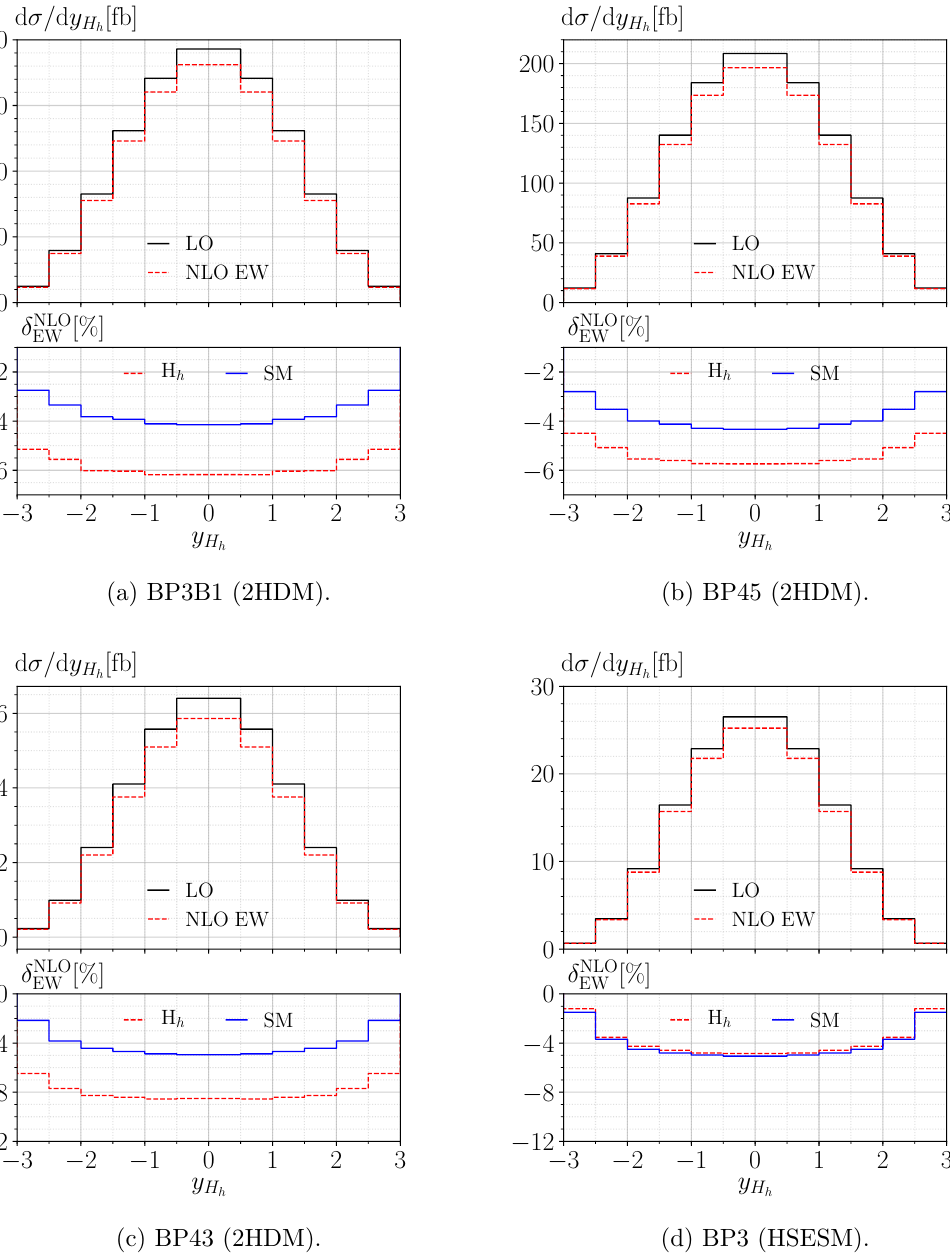
Figure 6. Distributions in the rapidity of the Higgs boson y for the benchmark points BP3B1 in (a), BP45 in (b) and BP43 in (c) in the 2HDM, and BP3 in (d) in the